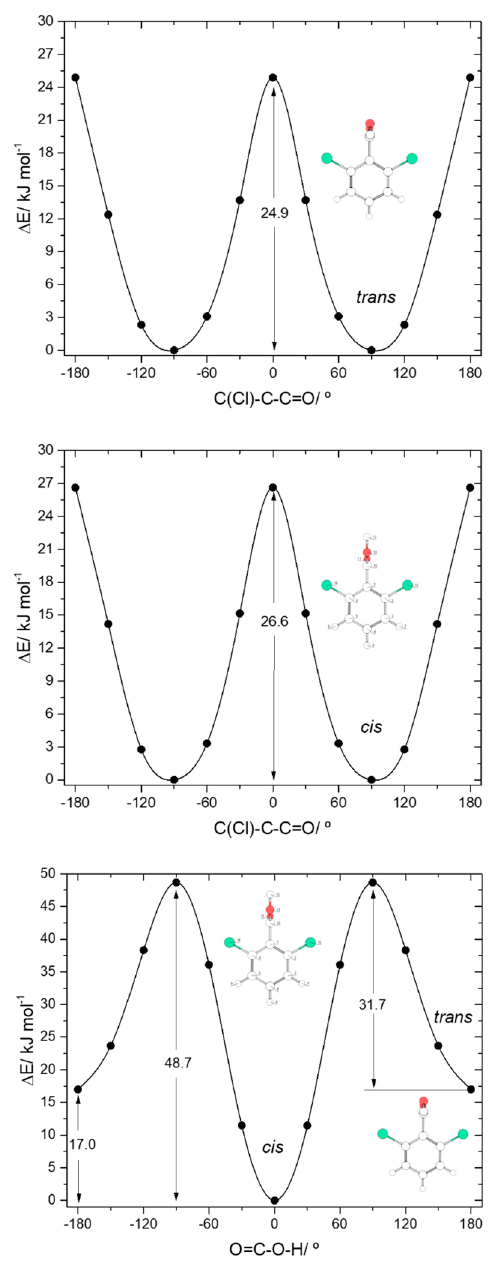
Figure 7. B3LYP/6-311++G(d,p) calculated potential energy profiles for internal rotation about the exocyclic C-C (for cis and trans arrangement of the carboxylic group) ( top and middle panels ) and about the C-O bond (connecting the cis and trans conformers; bottom panel ) for 2,6-dichlorobenzoic acid.